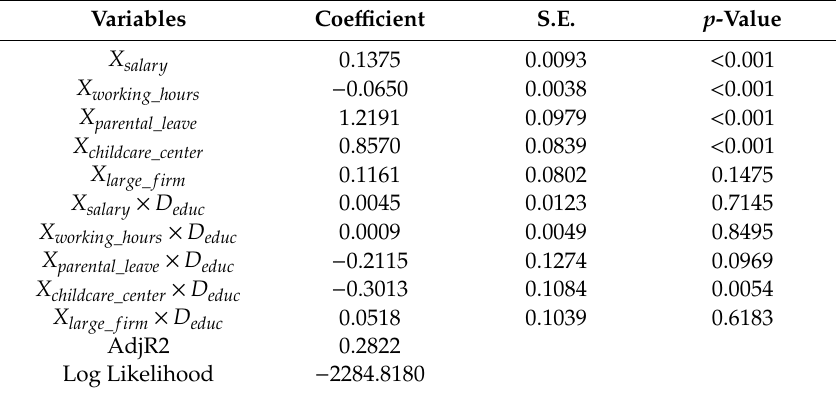
Table 9. Estimation results of the indirect utility function, by level of education.